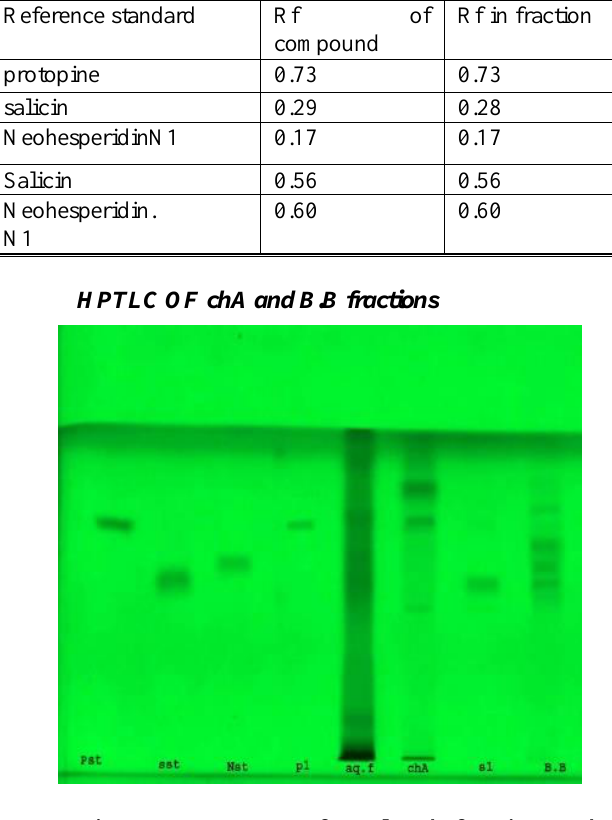
Figure1. HPTLC plate analyzed fraction with reference standard detection under UV light at 256nm (b.b=butanol before hydrolysis fraction, Sst=salicin standard ,N1= neohesperidin standard , S1 = isolated compound from b.b fraction) developed in [chloroform : methanol : acetic acid( 70:20:10)] solvent system. symbolized M4.